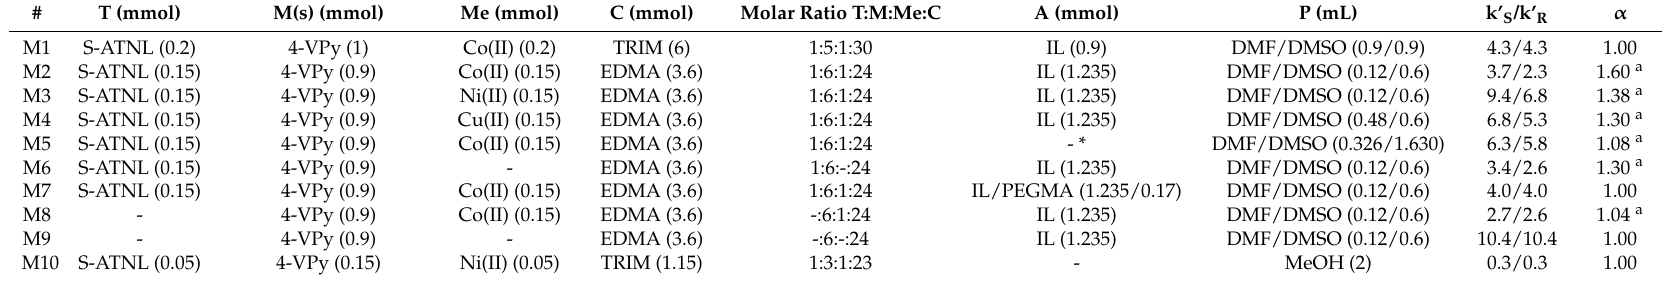
Table 2. Chromatographic retention (k’) and enantioselectivity ( α ) of various MIP-CSPs tested in monolithic columns (M1–10) with 4-VPy as functional